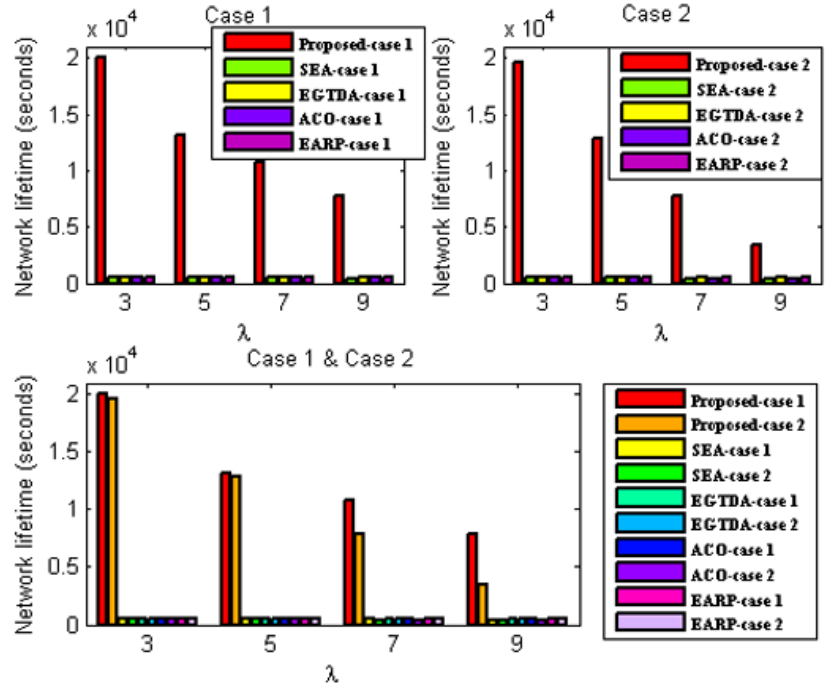
Figure 7. Influence of increasing average traffic rate on network lifetime under the second sce- nario.